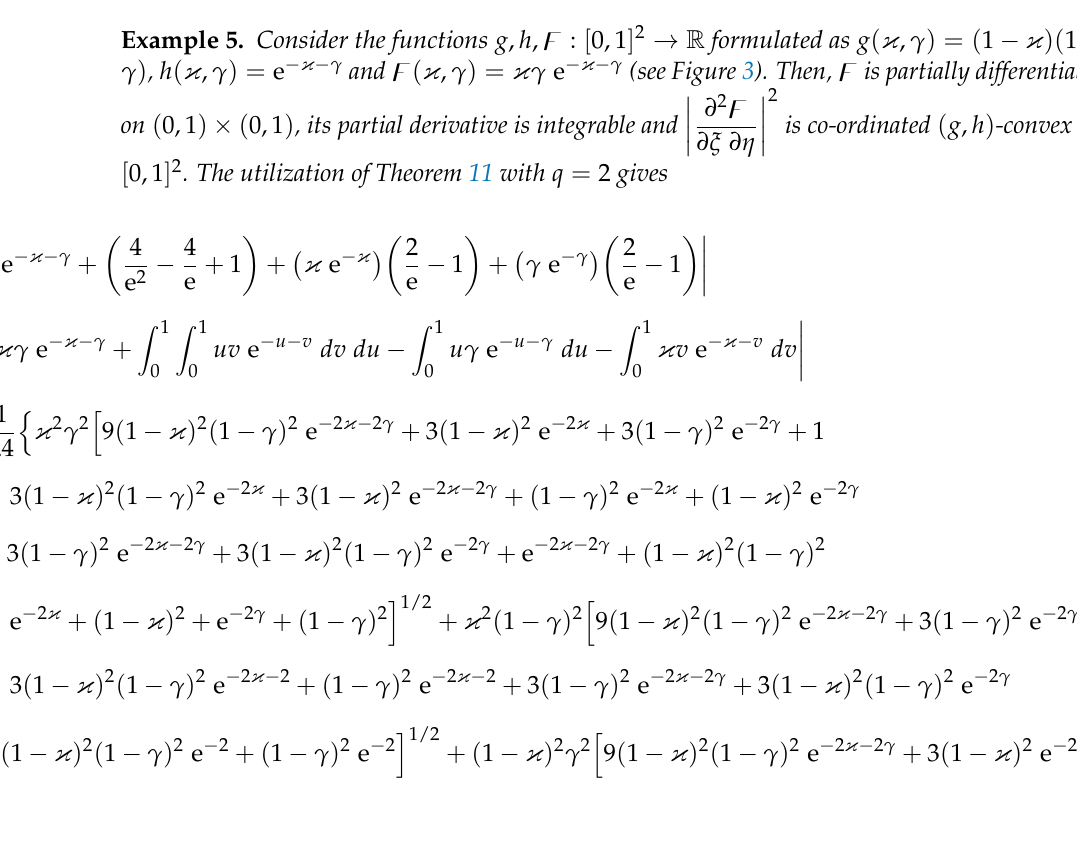
Figure 2. The image description for Theorem